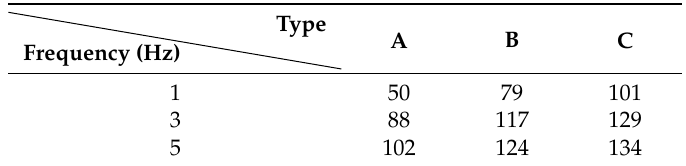
Table 1. Vibration testing output.